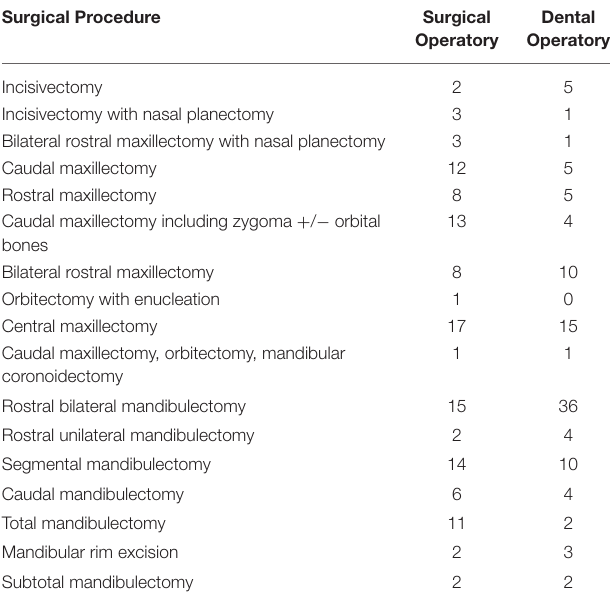
TABLE 1 | Description of the type of surgical procedures performed and number of each procedure performed. Surgical Procedure Surgical